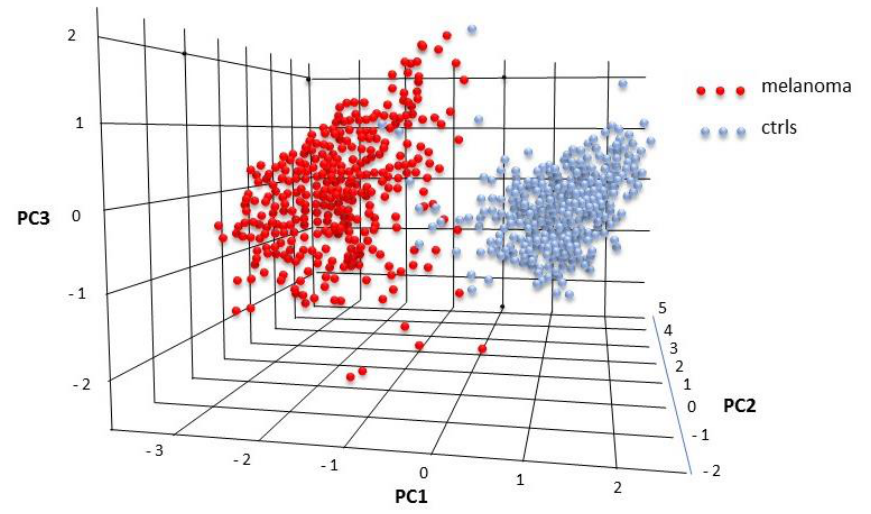
Figure 10. PCA analysis on the tissue expression values of IL-1Ra, IL-7, MIP-1a, and MIP-1b .